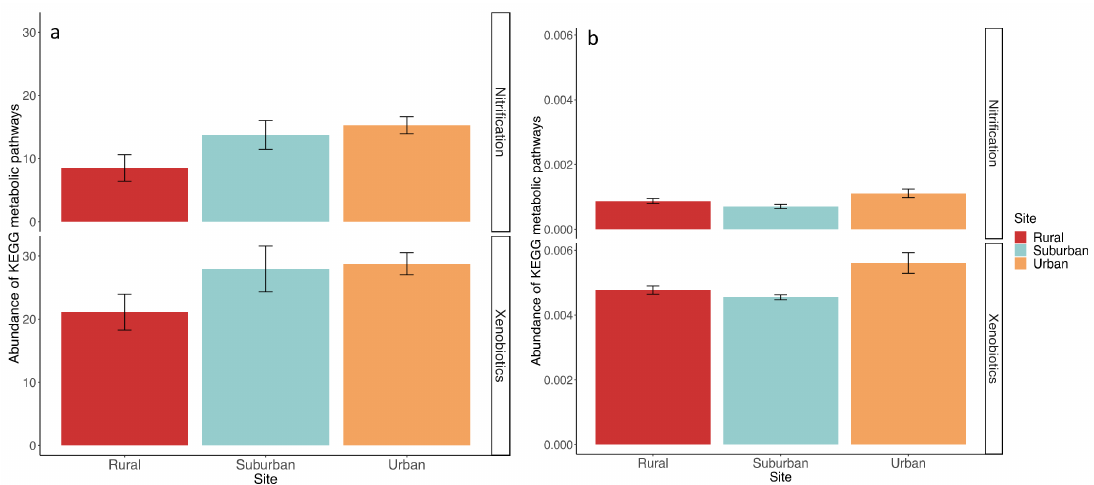
Figure 4. Bar plot showing mean abundance and standard error of metabolic pathways of nitrification and xenobiotic biodegradation across sites in Buenos Aires ( a ) and Washington D.C. ( b